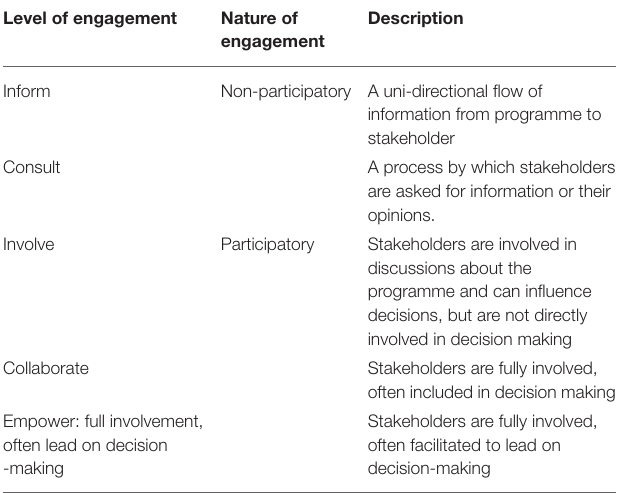
TABLE 2 | Different “Levels” of and “scales” of stakeholder engagement (elaborated by authors from IAP2, 2014). Level of